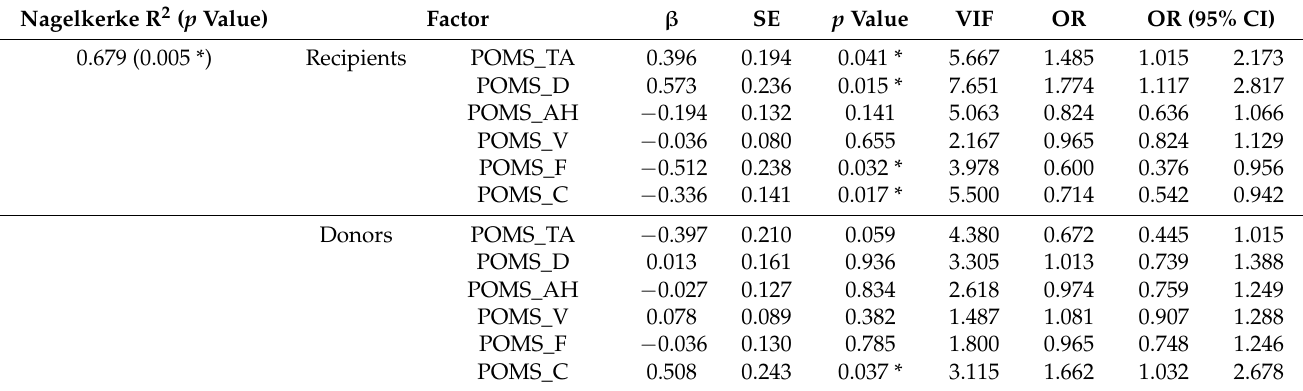
Table 4. Significant impact factors of POMS on choosing between PEKT and PDKT. * p < 0.05, ** p < 0.01 according to binomial logistic regulation analysis with robust standard errors. Multicollinearity was suspected if the VIF value was greater than 10. * p < 0.05, ** p < 0.01: significant impact factor on choosing between PEKT and PDKT for recipients and donors.